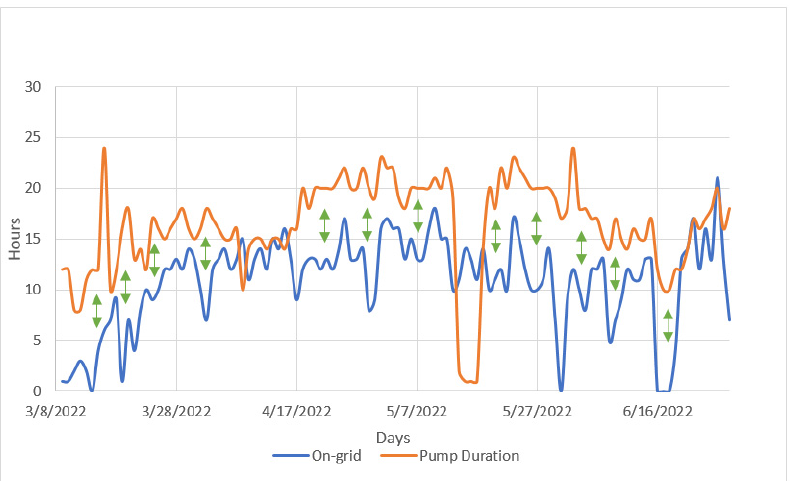
Figure 9. On-grid electricity supply and running time of water pumps in hours per day. Green arrows signify the energy gap covered by renewable energy due to national grid outages. Source: Authors.